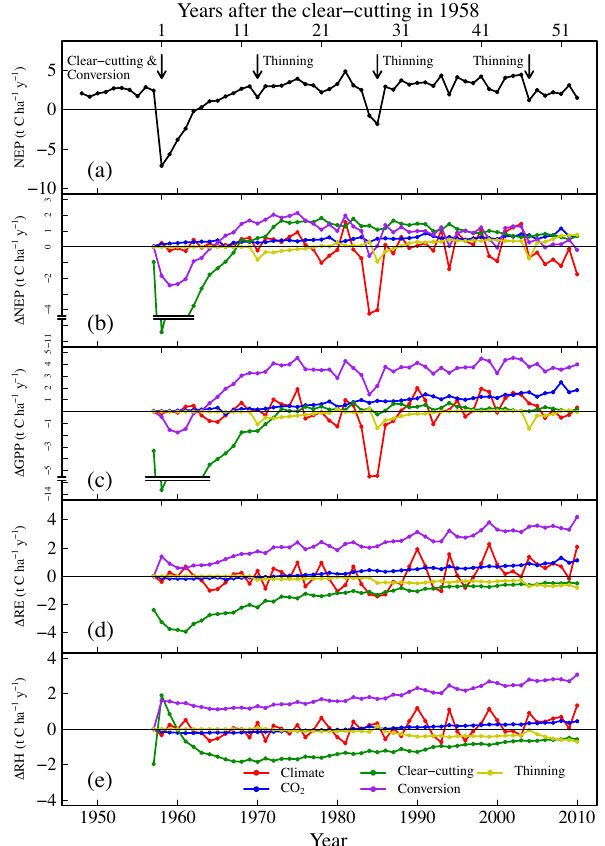
Figure 2. Effects of climate, CO 2 , thinning, land-use change, and disturbance on (a) annual net ecosystem production (NEP), (b) NEP ( 1 NEP), (c) gross primary production ( 1 GPP), (d) ecosys- tem respiration ( 1 RE), and (e) heterotrophic respiration ( 1 RH) at the Tomakomai site. The 1 values for climate, CO 2 , clear- cutting, and conversion were calculated by subtracting each flux of S const − climate , S const − CO2 , S non − cut , and S non − conversion from each flux of S non − thin . The 1 values for thinning were evaluated by subtracting each flux of S const − thin from each flux in the full sce- nario ( S full ) . Positive 1 values represent the enhancement effects on each flux, and negative values indicate the